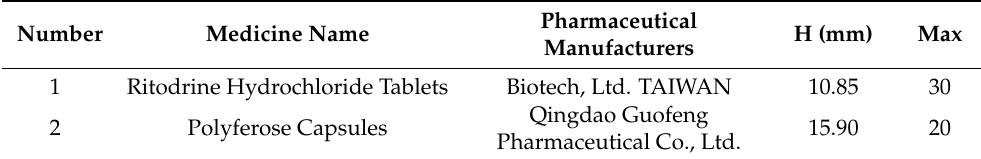
Table 4. Medicine information of test